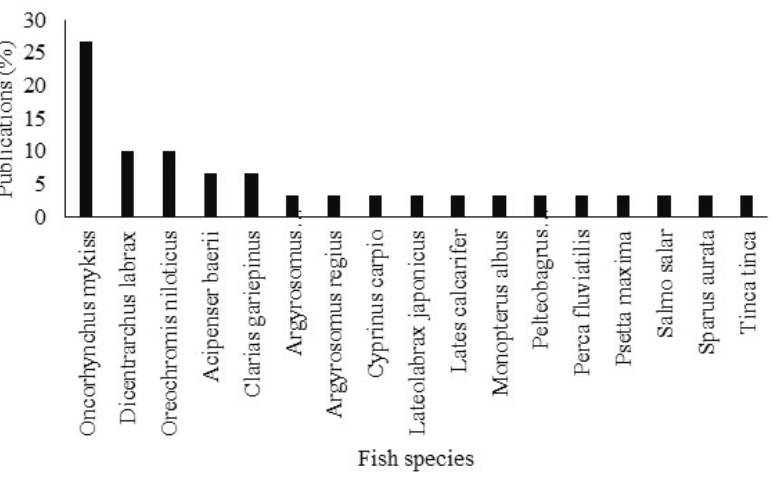
Figure 2. Relative abundance of fish species by publications identified in the meta ‐ analysis.